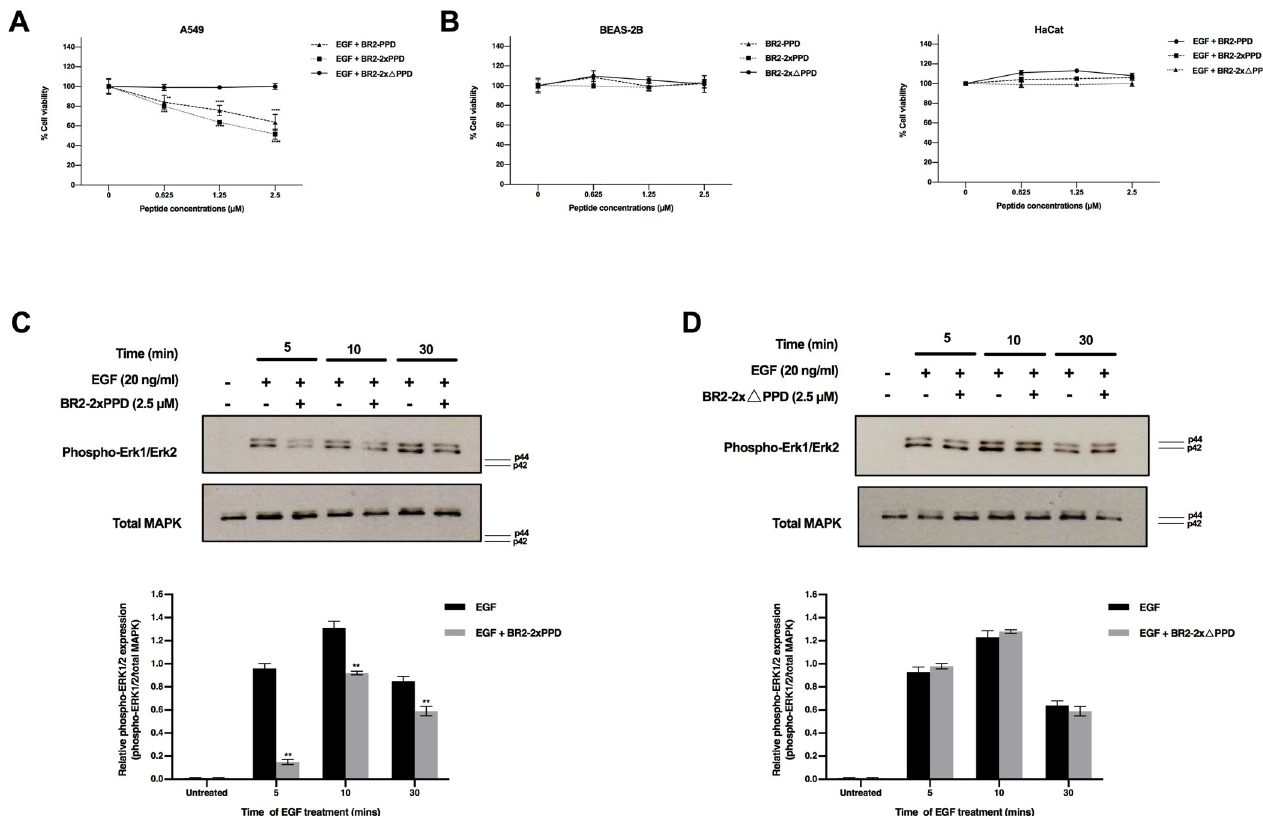
Fig 2. Effect of BR2-PR-PPD peptides on EGF-induced cell proliferation. (A) A549 cells were plated in RPMI supplemented with 1% DCC-FBS and 1% PenStrep at 6,000 cells per well in a 96-well culture plate and incubated for 24 h. The following day, the culture medium was removed. A549 were treated with EGF 50 ng/ml compared to the combination of EGF 50 ng/ml with increasing peptides (0, 0.625, 1.25 and 2.5 μ M) for 24 h. Cell viability was analyzed by MTT assays. Cell viability of A549 treated with BR2-PPD, BR2-2xPPD peptides was significantly decreased than BR2-2x Δ PPD (control) ( �� p � 0.01) ( ��� p � 0.001) ( ���� p � 0.0001). Error bars represent the standard errors of the mean (n = 3). (B) BEAS-2B 8,000 cells were plated in serum-free BEGM medium. After 24 h, cells were treated with increasing dose of peptides (0, 0.625, 1.25 and 2.5 μ M). HaCaT cells were cultured in 1% DCC-RPMI plus 1% PenStrep at 8,000 cells per well and incubated for 24 h. Next, cells were treated with EGF 50 ng/ml or combined with increasing concentration of peptides (0, 0.625, 1.25 and 2.5 μ M) for 24 h. Cell viability was analyzed by MTT assays. (C) and (D) A549 2x10 5 cells were cultured in 2% DCC-RPMI medium for 24 h. Cells were pre-treated with BR2-2xPPD or BR2-2x Δ PPD 2.5 µ M for 4 h. Then, cells were induced with EGF 20 ng/ml for 5, 10 and 30 min to activate MAPK signaling. Phospho-Erk1/2 and total MAPK were recognized by western blotting compared to untreated cells. Ten micrograms of protein were loaded in each lane. Bar graphs show relative pMAPK activities (pMAPK/totalMAPK) ( ���� p � 0.0001) and data are shown as means ± SEM (n =